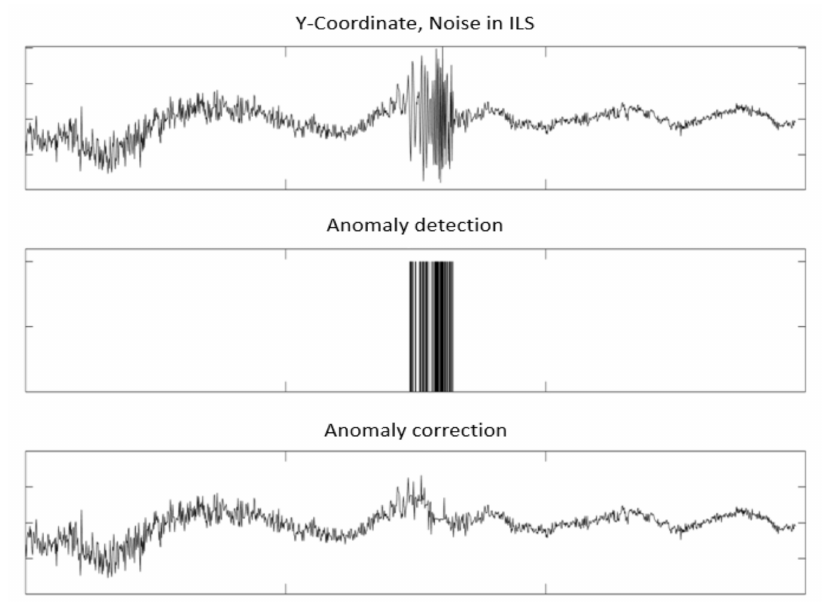
Figure 24. Anomaly detected and corrected using